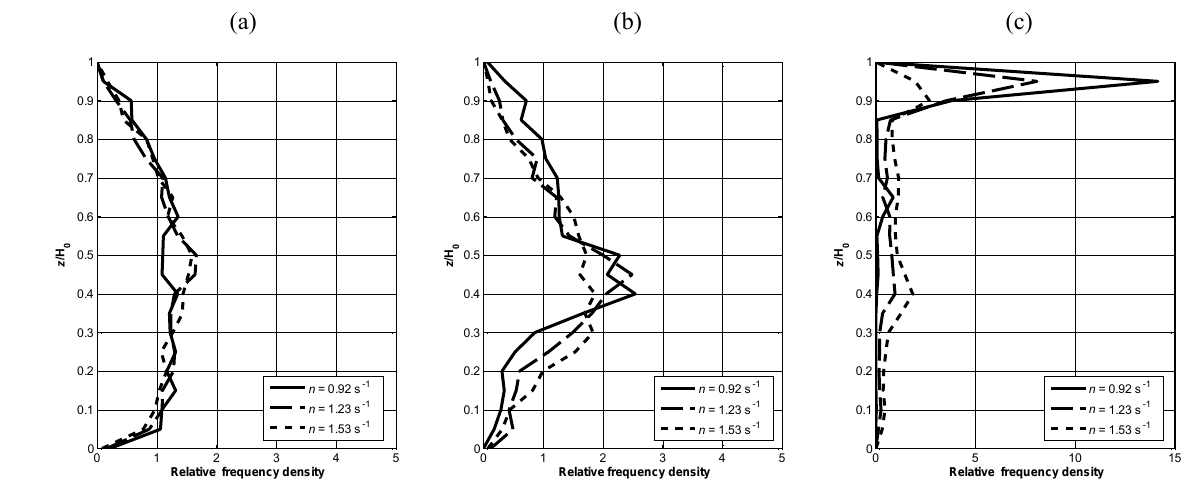
Figure 4. Vertical residence profiles of the sensor particles from the experiments in the stirred vessel for characterization of the required density offset at the impeller speeds of 0.92, 1.23 and 1.53s − 1 with different density ρ SP of the sensor particles at the fluid density ρ f :